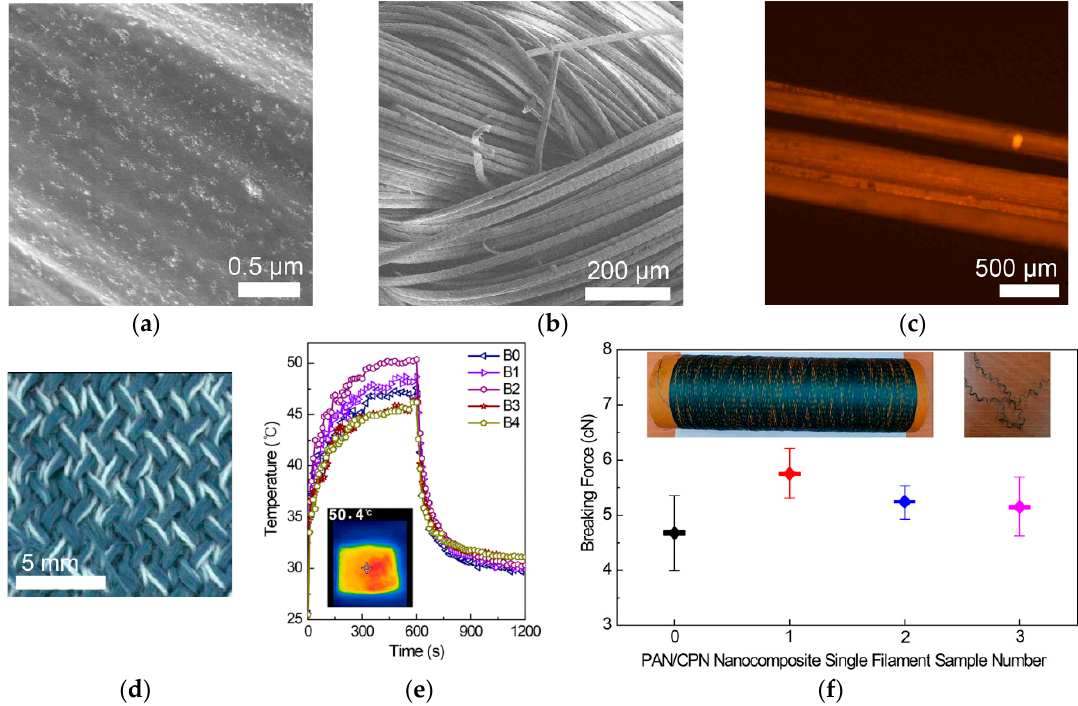
Figure 7. SEM images of ( a ) a nanocomposite fiber of PAN with 0.75 wt % CPNs, ( b ) fabric based nanocomposite fibers, ( c ) fluorescent (excited at 650 nm) images of yarn based on nanocomposite fibers, ( d ) an optical image of fabrics prepared from yarns based on PAN/CPN nanocomposite fibers, ( e ) photothermal response of the textiles fabricated using PAN/CPN nanocomposite fibers at 0.75 wt % of CPNs under white light irradiation for the first 600 s, followed by 600 s after turning off the light, with an infrared thermal image under white light irradiation at t = 600 s, and ( f ) breaking forces measured by single filament tensile experiments of pristine PAN fibers (filament 0), nanocomposite fibers before knitting the textiles (filament 1, left inset image), after knitting followed by deknitting without washing (filament 2), and after washing in a laundry machine followed by deknitting (filament 3, right inset image). Reproduced from Ref. [102].